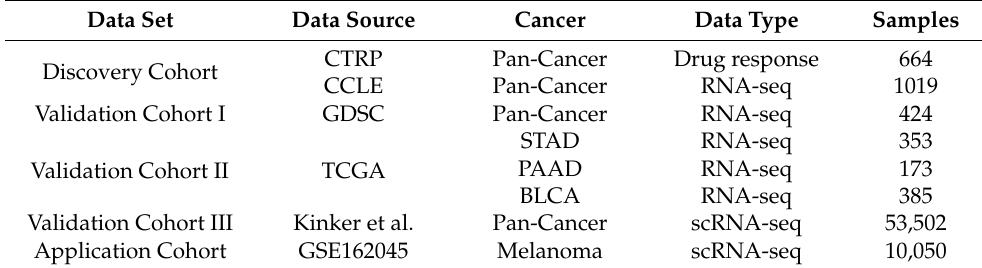
Table 1. Summary of data cohorts used in this